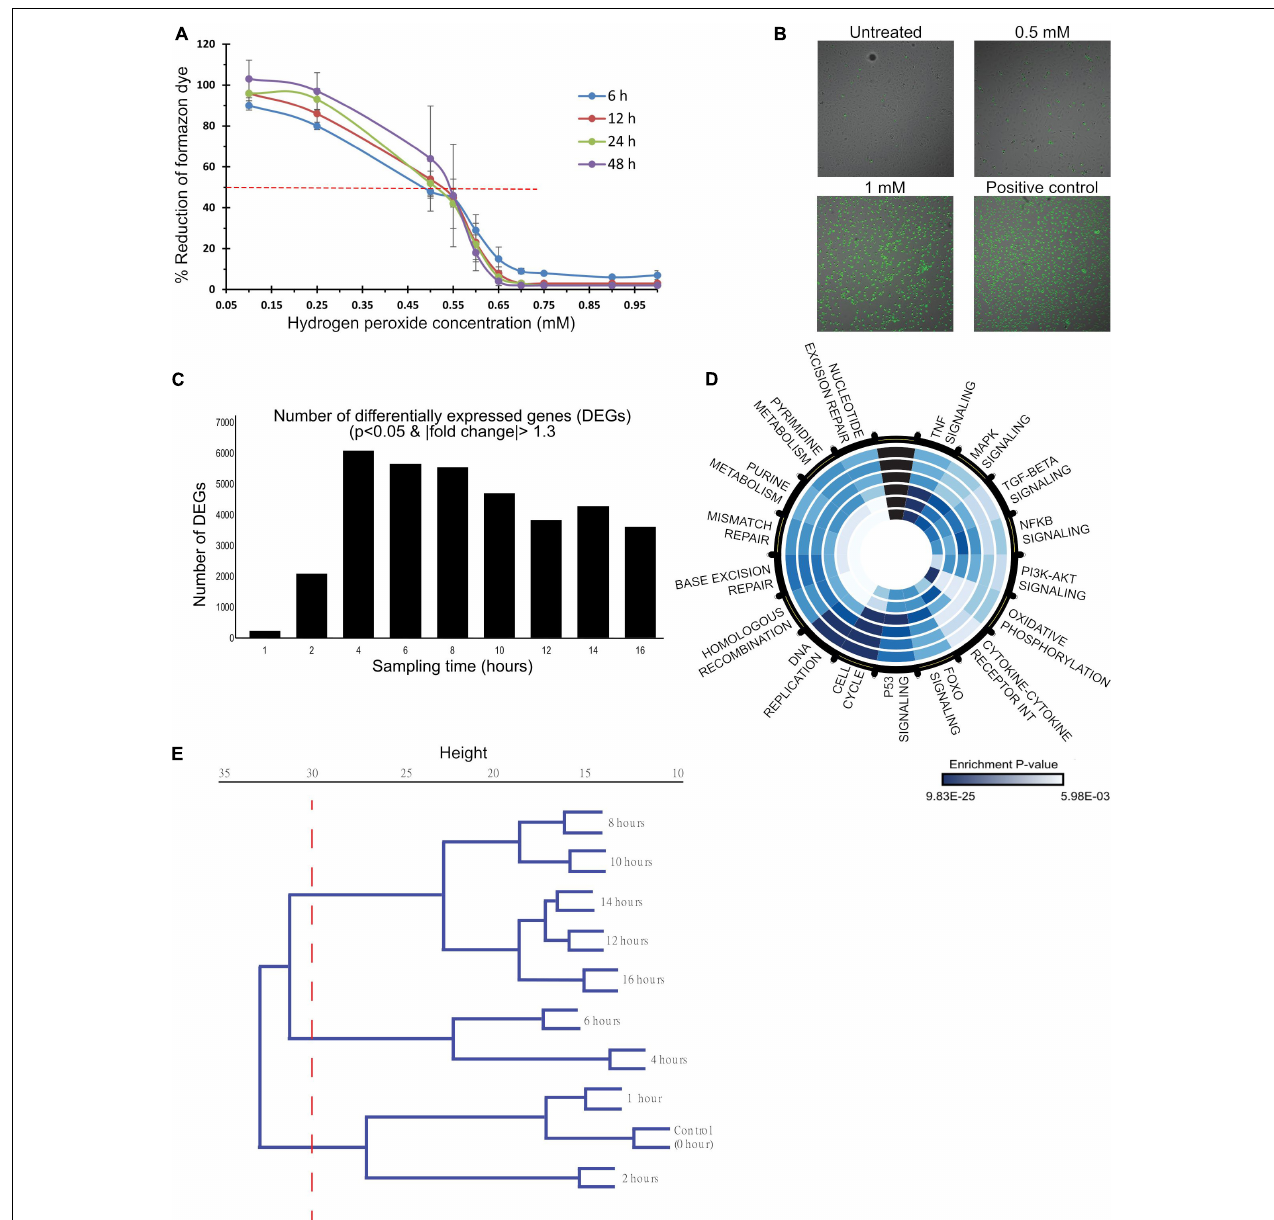
FIGURE 1 | A dose- and time-dependent analysis of HP induced oxidative stress in HUVECs. (A,B) HUVECs were treated with 0–1 mM HP, and functional measurements were made to characterize the dose-dependent response to oxidative stress. (C–E) mRNA samples, collected at 0, 1, 2, 4, 6, 8, 10, 12, 14, and 16 h post-treatment (0.5 mM HP), were sequenced to characterize the time-dependent response to oxidative stress. (A) Dehydrogenase activity was measured as a proxy for cell metabolic capacity. Blank adjusted measurements are reported as a percentage of the negative control (untreated cells) at 6, 12, 24, and 48 h post-treatment. Three biological experiments ( n = 3), each had four technical replicates. (B) Cyto-Tox Green assay: the amount of green staining is proportional to cytotoxicity. Scale bar: 20 µ m. Three biological experiments ( n = 3), each had two technical replicates. (C) The number of differentially expressed genes at each time point post-HP treatment to control (0 h); DE genes were identified by a p -value cutoff of 0.01 and a | fold-change| cutoff of 1.3. (D) Significantly enriched KEGG pathways. Each ring of the circle represents one time-point, where the inner-most ring represents 1 h, and the outer-most ring represents 16 h. Dark blue indicates highly significant p -values, whereas light blue represents less significant p -values. (E) Hierarchical clustering dendrogram of normalized gene counts from each time point.